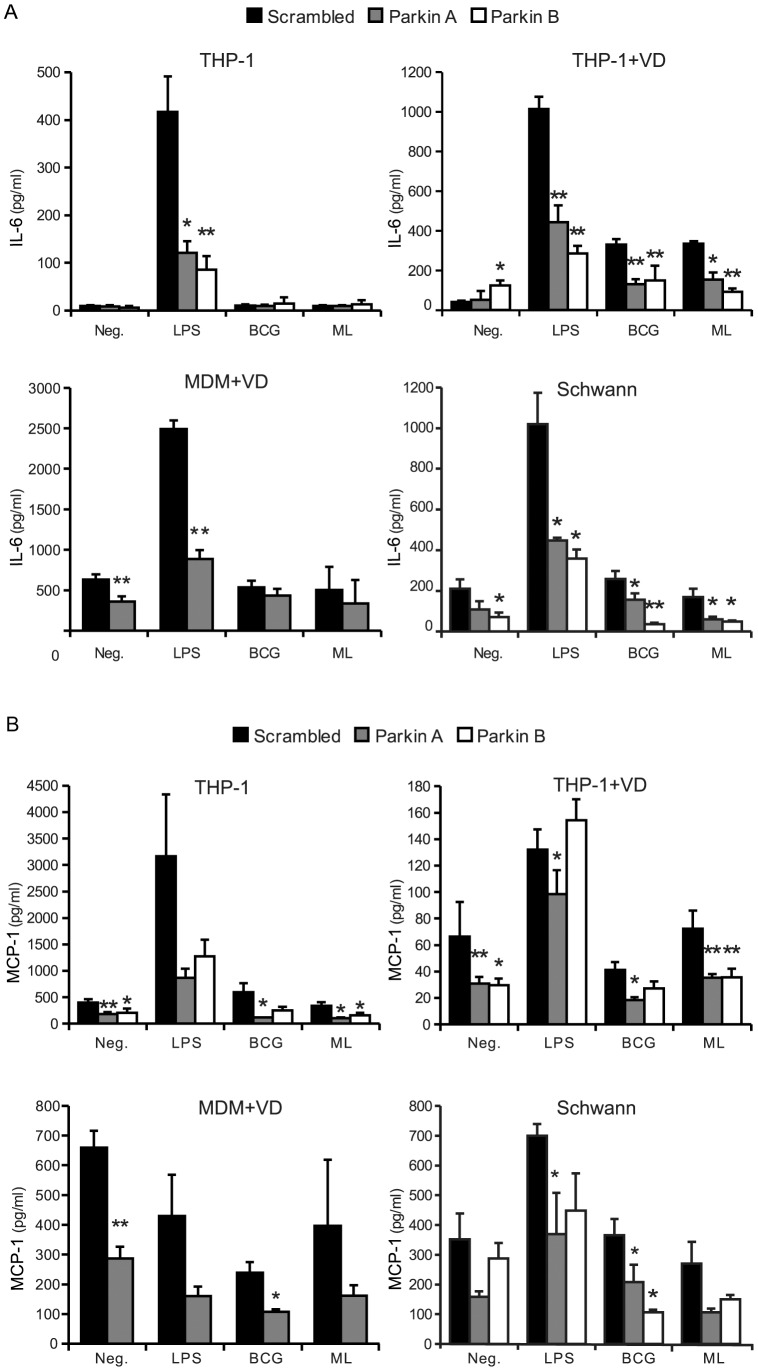
Parkin knockdown inhibits IL-6 and MCP-1 induction in macrophages and Schwann cells.PMA-differentiated THP-1 macrophages, VD-treated THP-1 macrophages, VD-treated human monocyte-derived macrophages and human Schwann cells were transfected with control or Parkin-silencing siRNA. Due to the limited number of cells available for each experiment, only one PARK2 siRNA was used for MDM. After 48 hours, cells were treated with LPS (10 ng/ml), M. bovis BCG at an MOI of 10, M. leprae (ML) at an MOI 50, or left untreated (Neg.). Supernatants were collected after 6 hours and analyzed for (A) IL-6 and (B) MCP-1. The charts show the average concentration of cytokine in the supernatant in pg/ml ± SD of at least three independent experiments for each cell type. Scrambled: control siRNA, Parkin A: siRNA(A) for Parkin, Parkin B: siRNA(B) for Parkin. * p<0.05, ** p<0.01, non-parametric t test of unpaired samples.